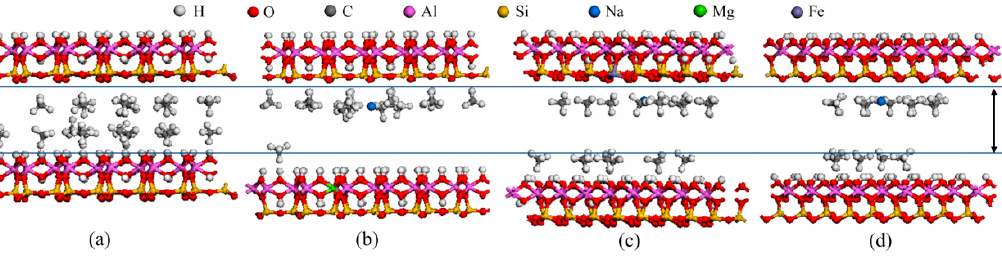
Figure 7. The snapshots of CH 4 adsorption. ( a ) pure kaolinite; ( b ) Mg-doped kaolinite; ( c ) Fe(II)-doped kaolinite; ( d ) Al-doped kaolinite.